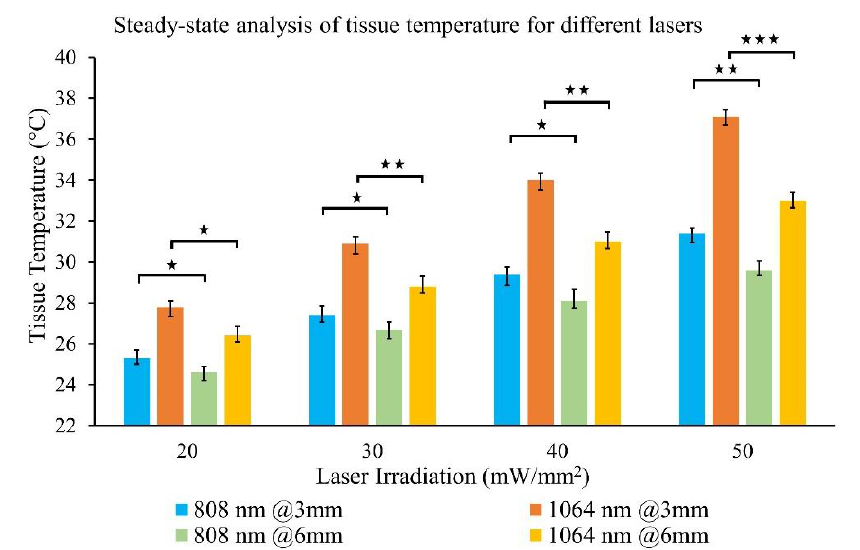
Figure 6. Steady-state temperature of ex vivo porcine pancreas tissue at 3 mm and 6 mm depth from top surface during photothermal heating at different laser irradiations (20, 30, 40, 50 mW·mm −2 ) of both 808 and 1064 nm wavelengths. The error bar represents mean ± 1 σ (standard deviation) for n = 5 trials. Statistical analysis (T-test) was conducted between results from 3 mm and 6 mm tissue depths for a fixed laser wavelength and irradiation. The significance of the data is represented by ★ symbol where ★ = p < 0.05, ★★ = p < 0.01, ★★★ = p < 0.001.